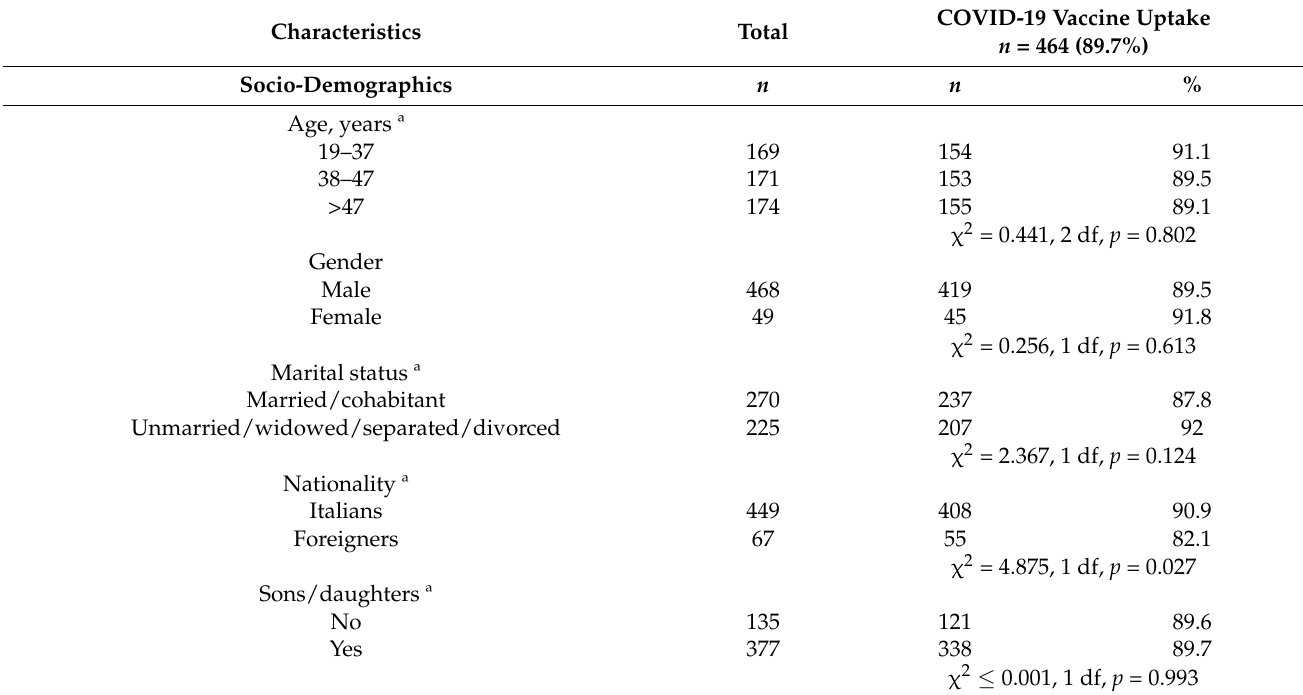
Table 2. COVID-19 vaccination uptake according to several population characteristics ( n = 517).